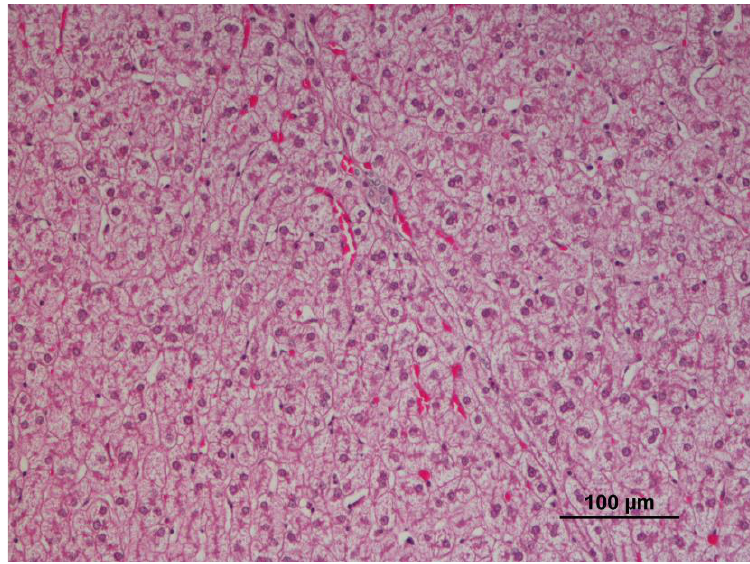
Figure 2. Panlobular hydropic change in the liver (10×, 10×).